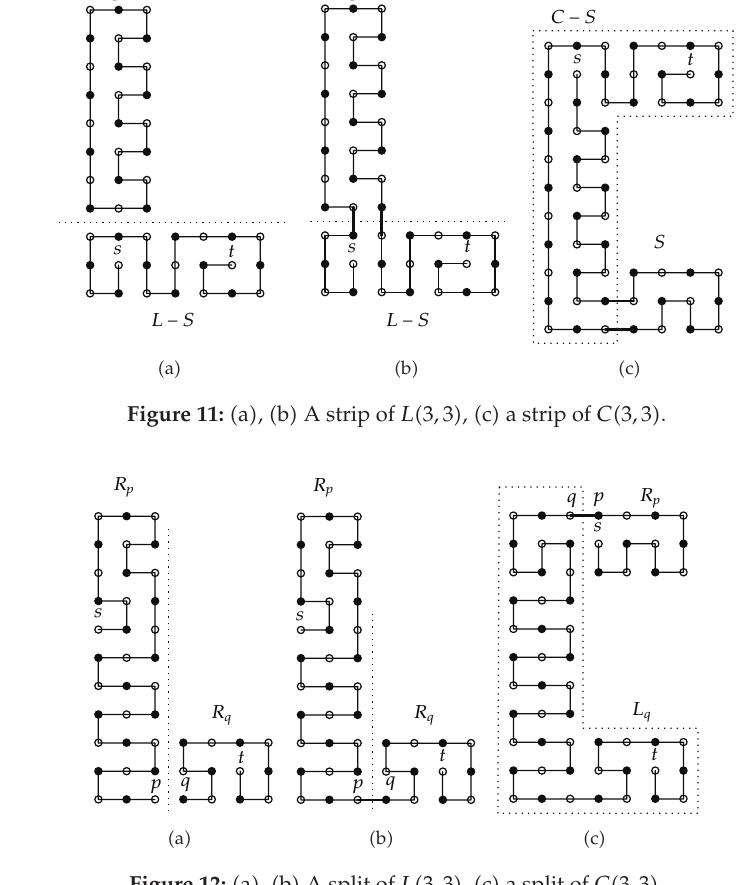
Figure 12: (cid:6) a (cid:7) , (cid:6) b (cid:7) A split of L (cid:6) 3 , 3 (cid:7) , (cid:6) c (cid:7) a split of C (cid:6) 3 , 3 (cid:7)